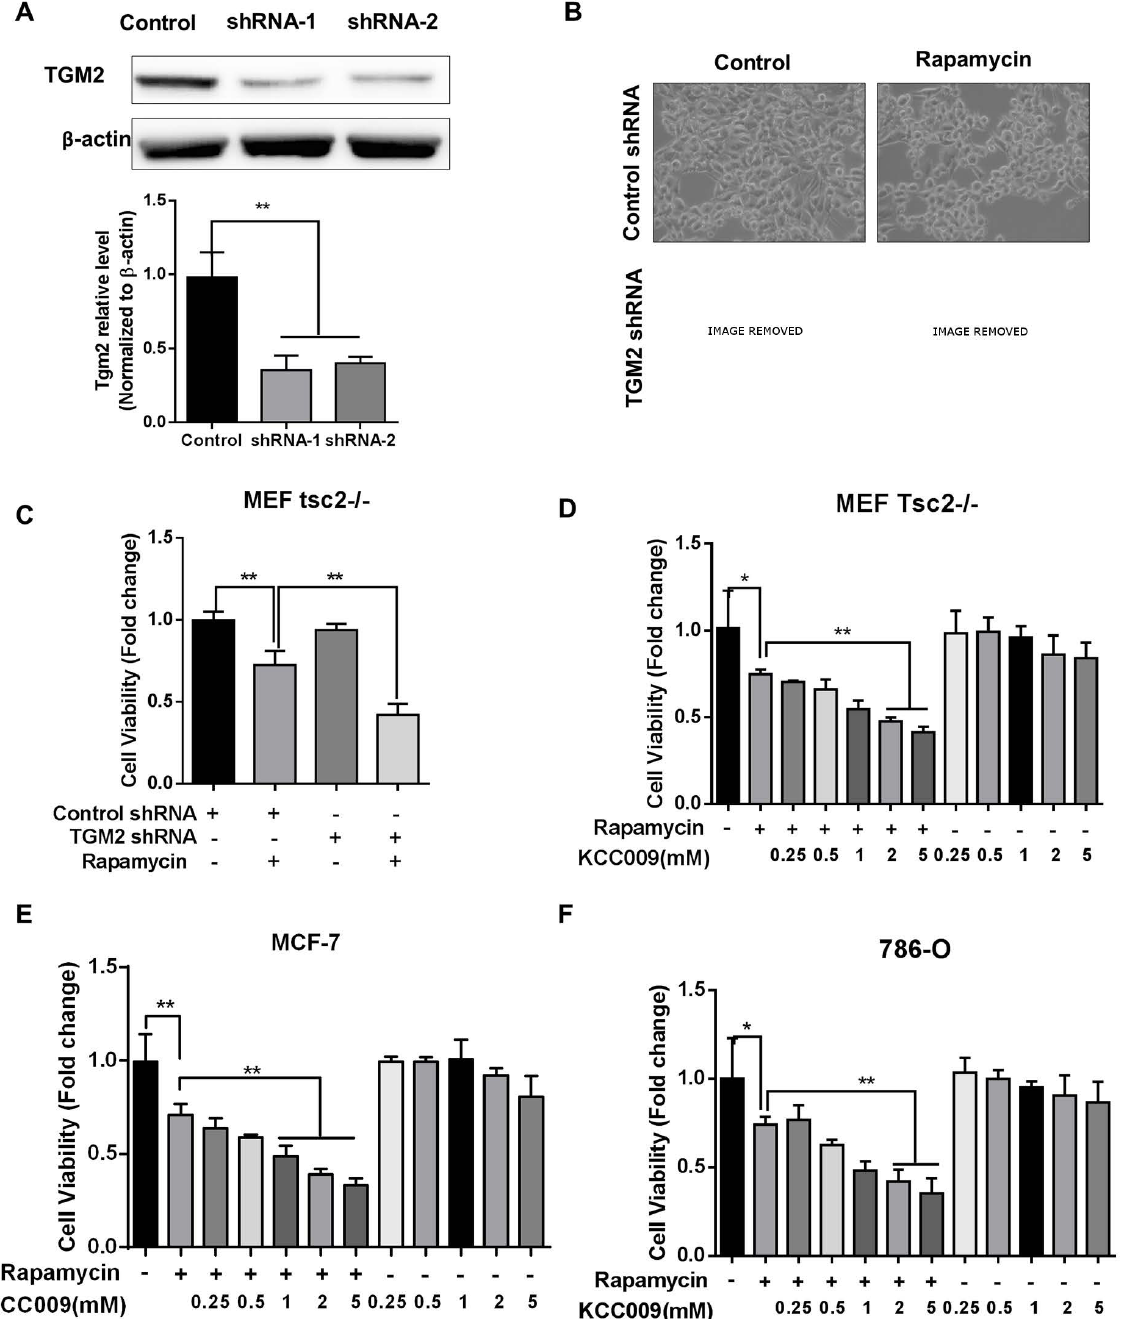
Fig 3. Combined TGM2 and mTORC1 inhibition leads to morphological changes and reduced viability. (A) Tsc2 -/- MEF cells were treated with siRNAs against TGM2 and lysates were used for immunoblotting. Densitometry is shown in the bar chart (n = 3). (B) Tsc2 -/- MEF cells were treated with either TGM2 siRNA or 20 nM rapamycin for 24 hours and cell morphologies were recorded using phase-contract microscopy. (C) Tsc2 -/- MEF cell viability following treatment with TGM2 siRNA and 20 nM rapamycin (n = 8). (D) Tsc2 -/- MEF cell viability following treatment with 20 nM rapamycin and the indicated doses of TGM2 inhibitor KCC009. (E) Viability of MCF-7 cells treated with 20 nM rapamycin and the indicated doses of TGM2 inhibitor KCC009 (n = 8). (F) Viability of 786-O cells treated with 20 nM rapamycin and the indicated doses of TGM2 inhibitor KCC009 (n = 8). All data are shown as means ± S.D. ** P < 0.01, * P < 0.05, Student ’ s